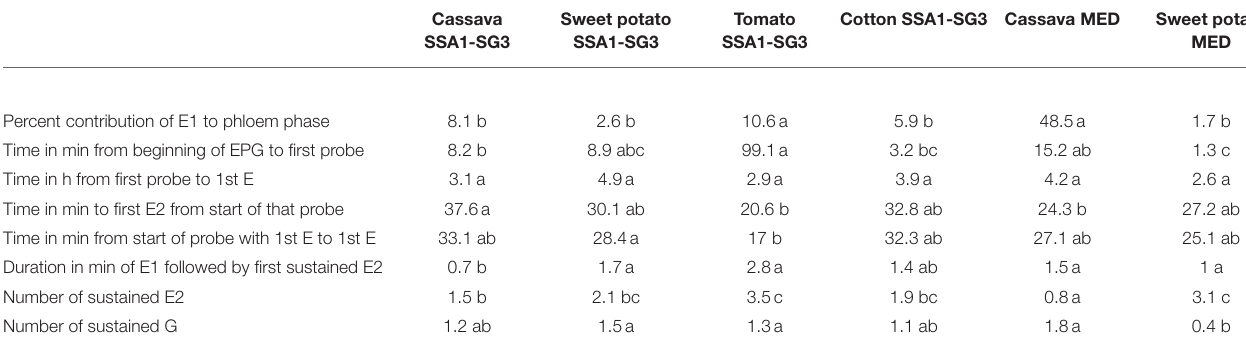
TABLE 4 | Selected detailed EPG parameters describing whitefly-plant